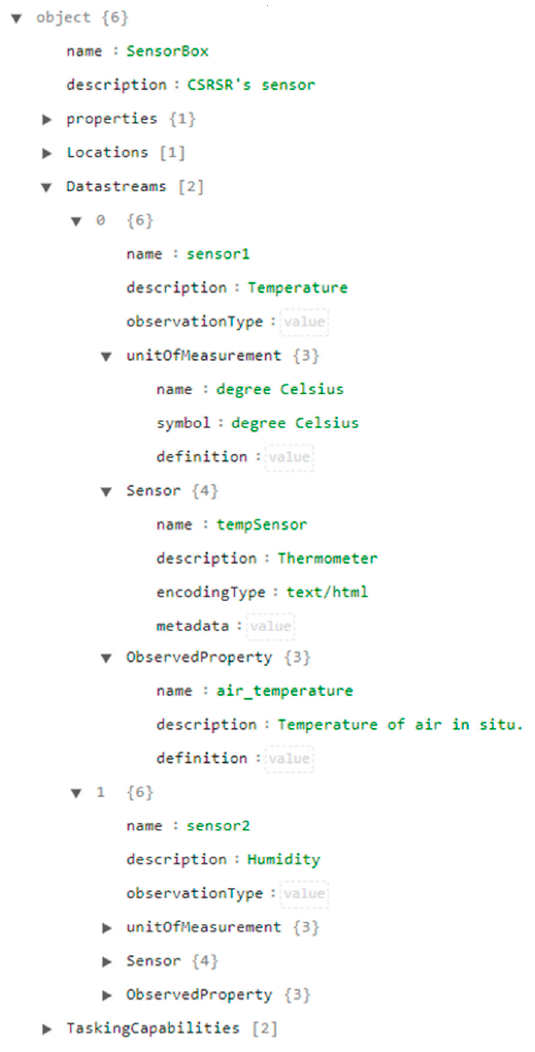
Figure 5. Sensing capability of an example description file.